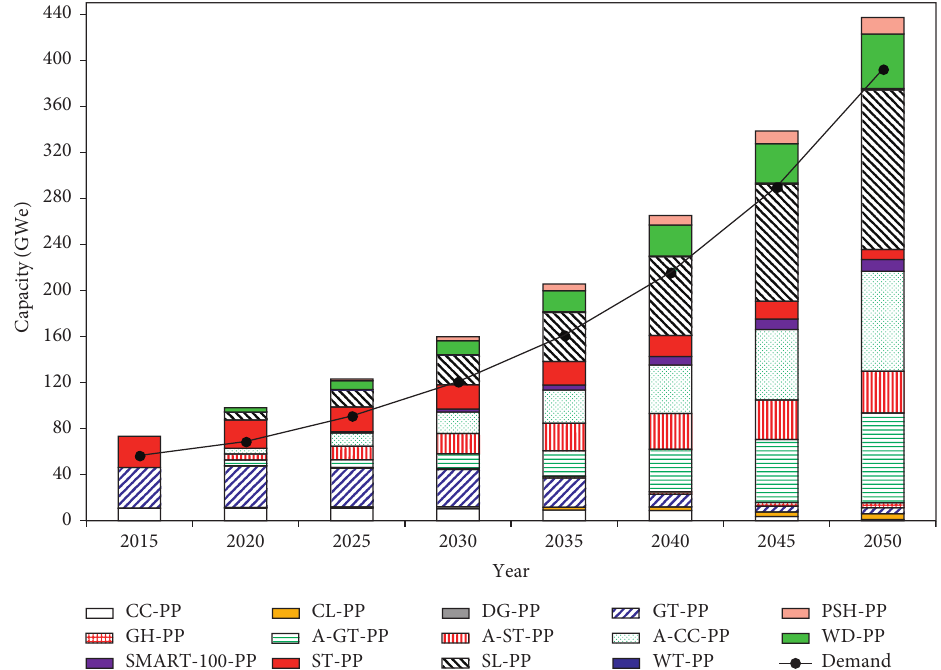
Figure 10: Simulation result from MESSAGE tool for Subscenario III-2.